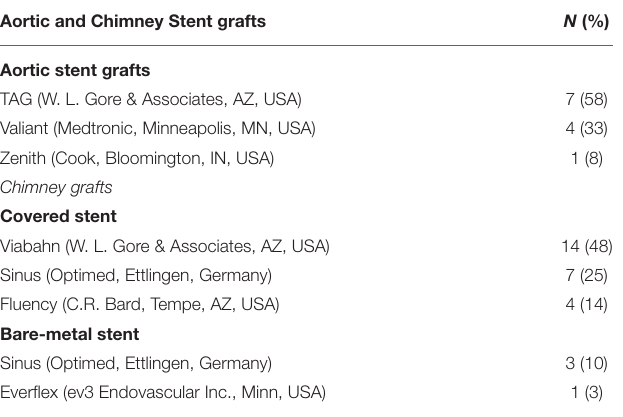
TABLE 3 | Characteristics of aortic and chimney stent grafts.